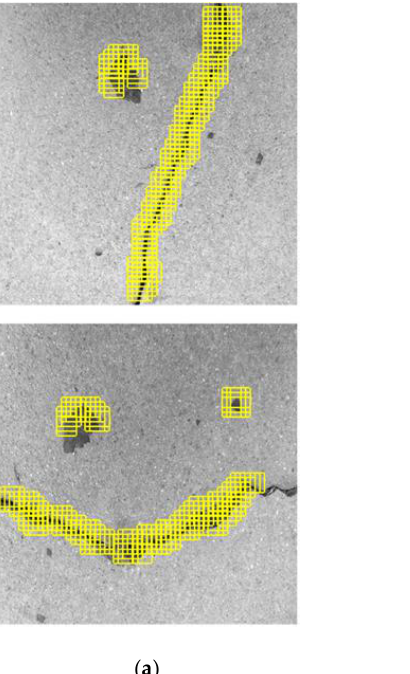
Table 4. Four test sets types and the number of pictures contained.